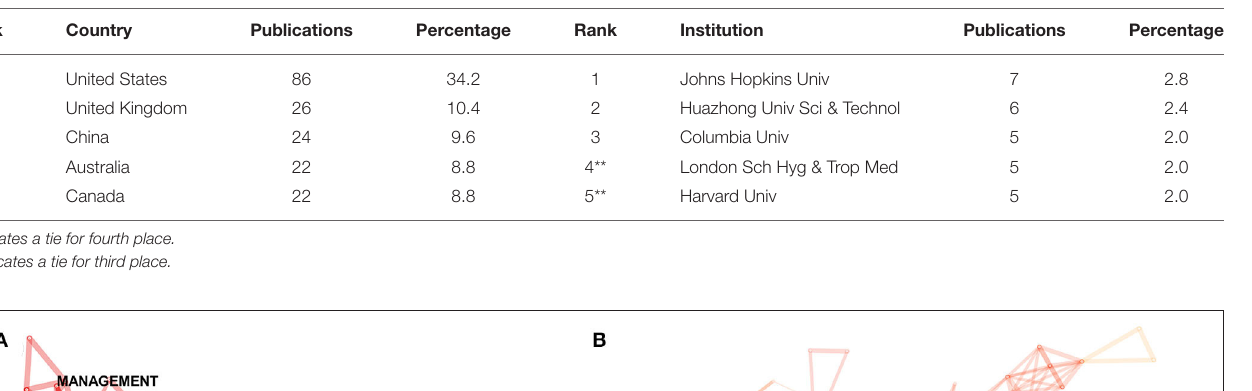
Advanced Nursing led the way with 82 co-citation counts,